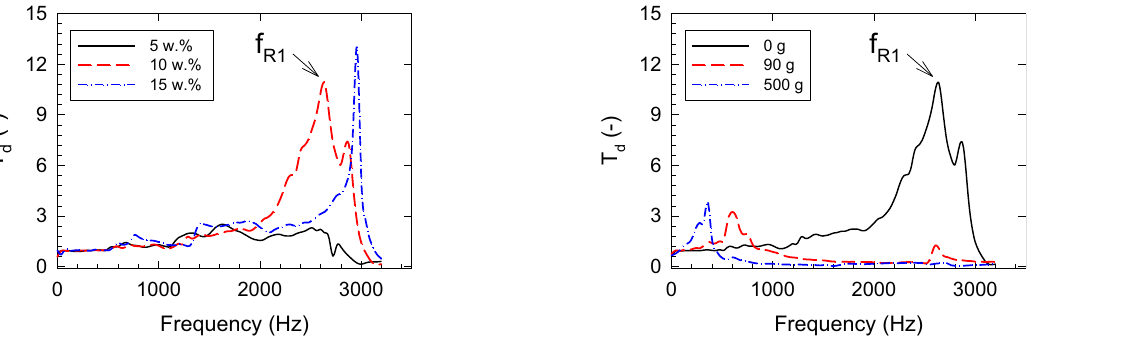
Figure 7: Frequency dependencies of the displacement transmissi - bility of the tested perlite/HDPE composites ( Inset: inertial mass ) of 10 wt% perlite